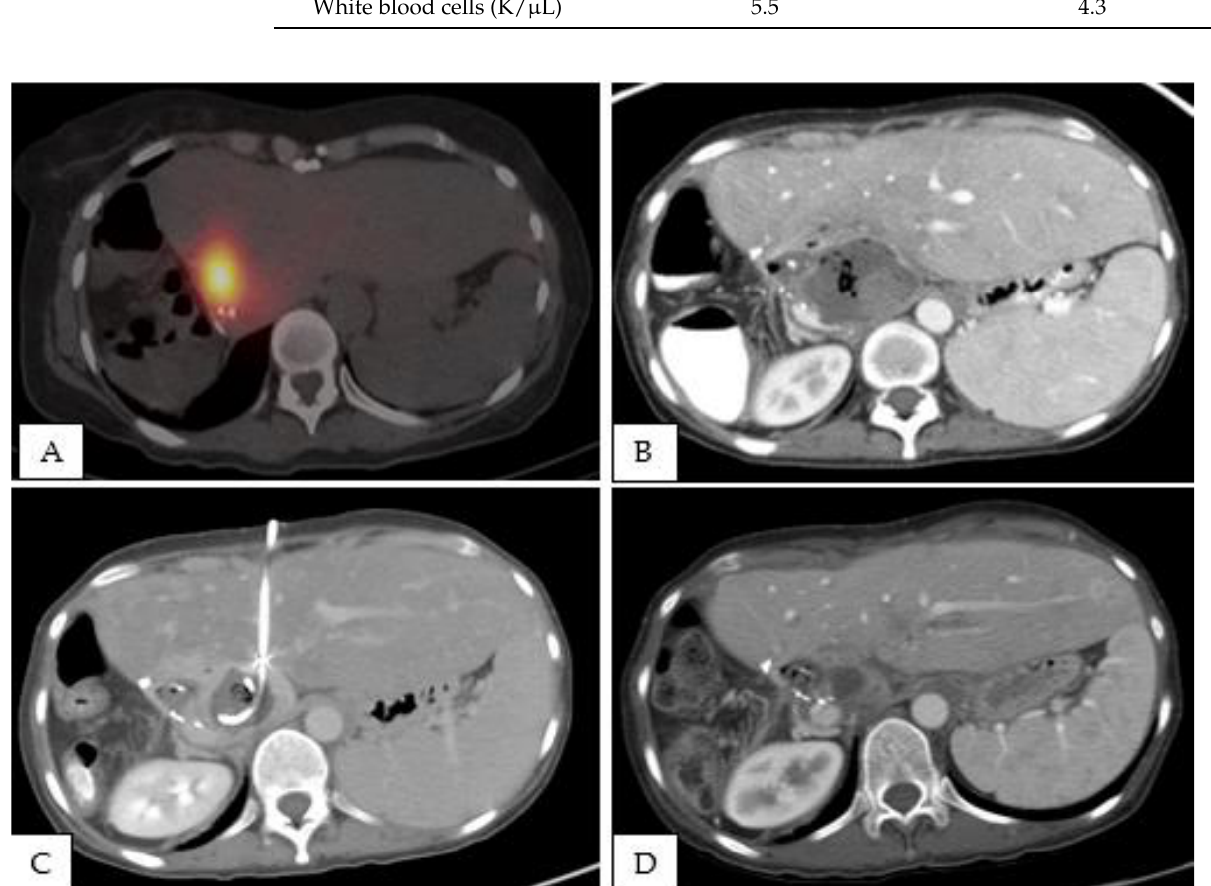
Figure 1. A 48-year-old woman with hepatocellular carcinoma and a history of hepaticojejunostomy received TARE. ( A ) SPECT CT following the 90 Y treatment. The patient presented with worsening abdominal pain, fever, and mild leukocytosis 71 days after 90 Y glass radioembolization. A contrast-